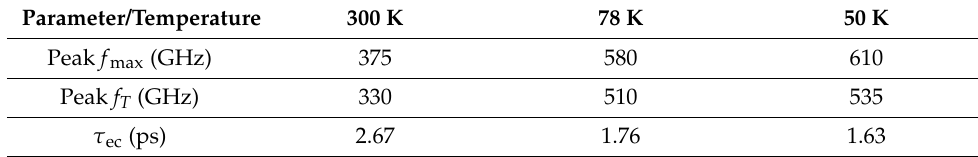
Table 3. The AC performance metrics of SiGe